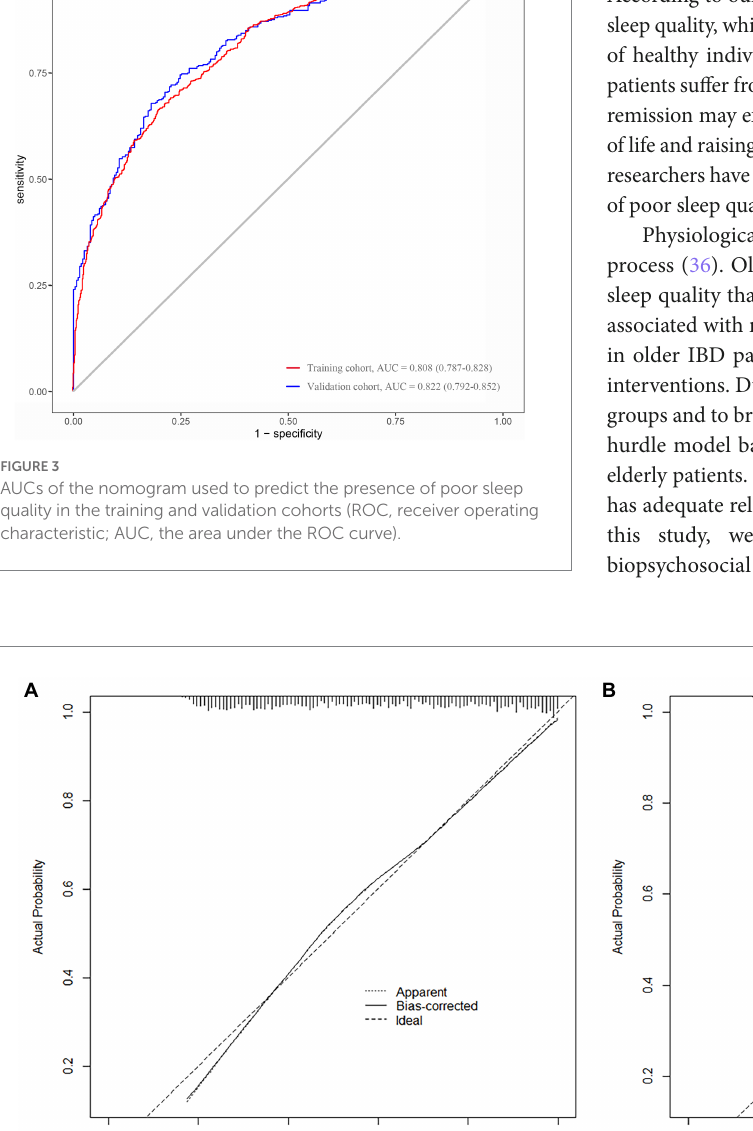
FIGURE 4 The calibration plots comparing predicted and actual poor sleep quality in the training (A) and validation (B)